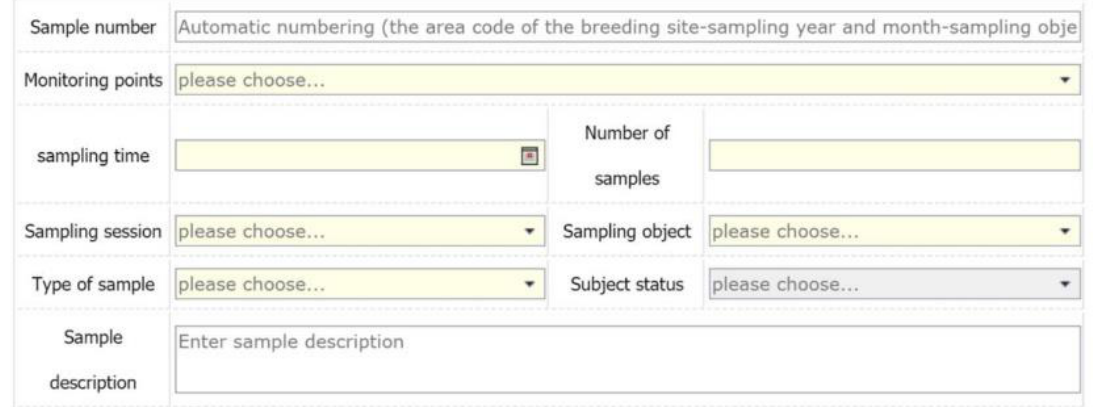
Figure 4. Data collection interface.